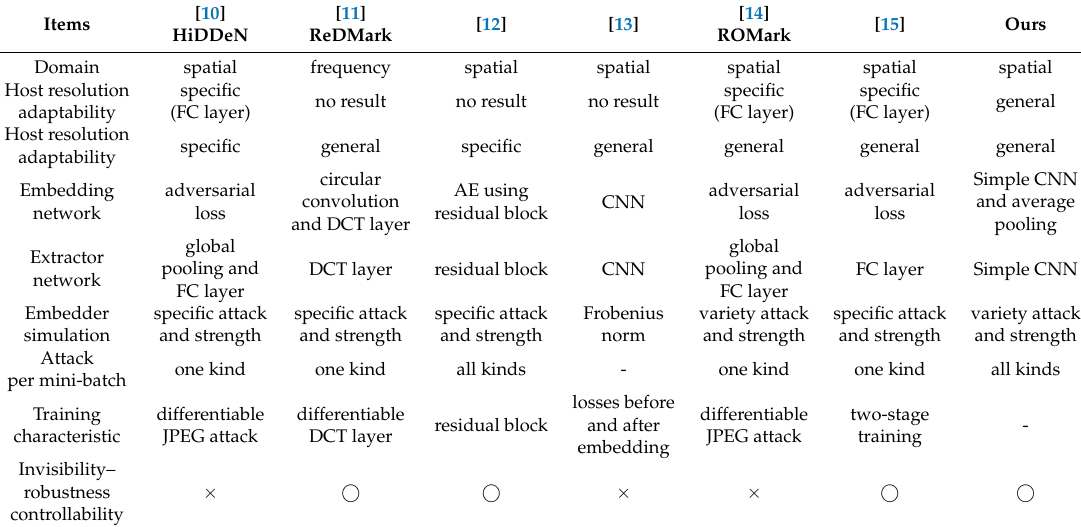
Table 1. Characteristics of state-of-the-art networks and